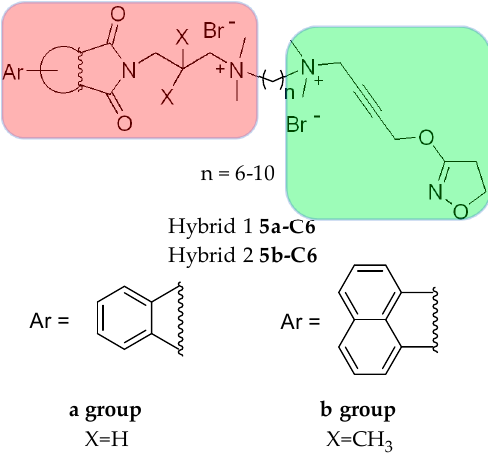
Figure 4. Structures of bitopic hybrids. 5a-C6, 5b-C6 M2 muscarinic hybrid. Green: orthosteric building block, red: allosteric building block.